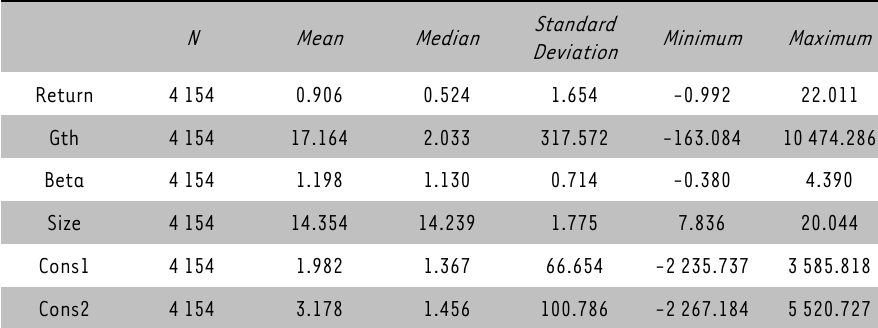
TABLE 1: Descriptive statistics Panel A: Distribution of